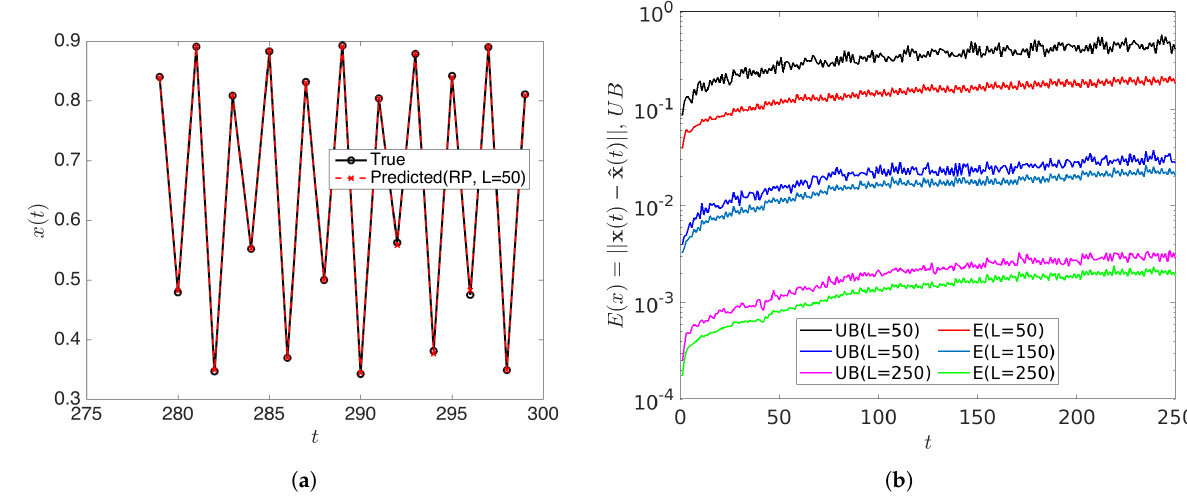
Figure 5. ( a ) Shows the predicted data using the rDMD algorithm with projected dimension L = 50 compared to the original data from logistic map x n + 1 = 3.56994 x n ( 1 − x n ) for initial condition x ( 0 ) = 0.4967. Further, ( b ) shows the estimated error and theoretical upper bounds (Equation (14)) for some projected dimension L , and this example validates the theoretical bound.